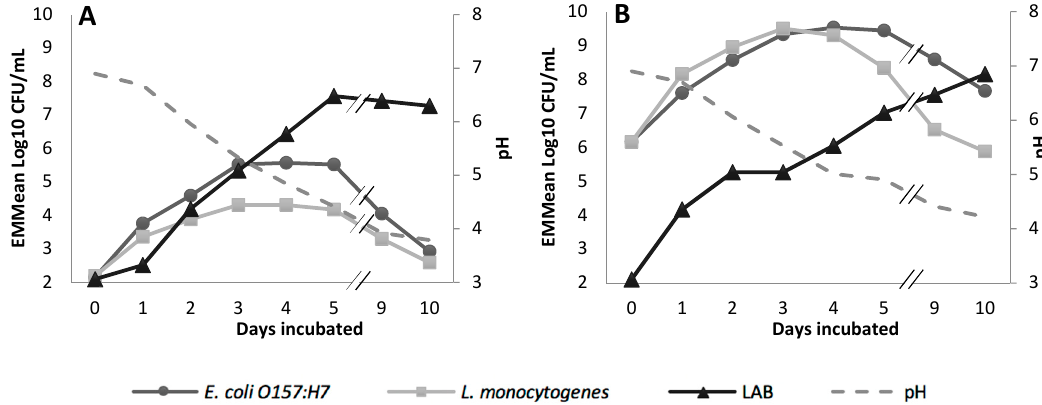
Figure 4. EMMeans of E. coli O157:H7, L. monocytogenes, lactic acid bacteria (LAB) and pH at a lower 10 2 ( A ) and higher 10 6 ( B ) pathogen inoculum level over 10 days at 22 °C.